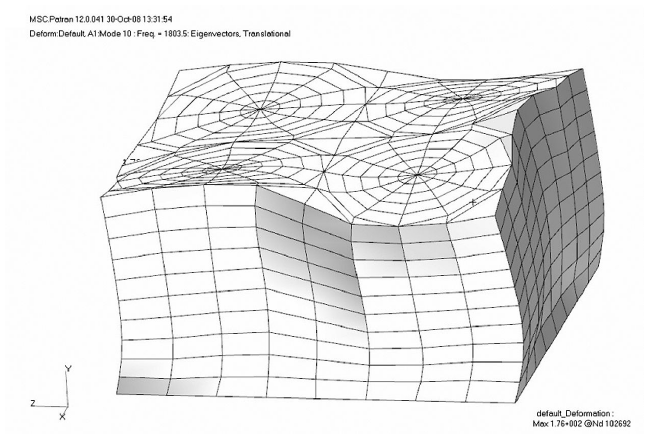
Fig. 23. 10th and 11th mode: 1803